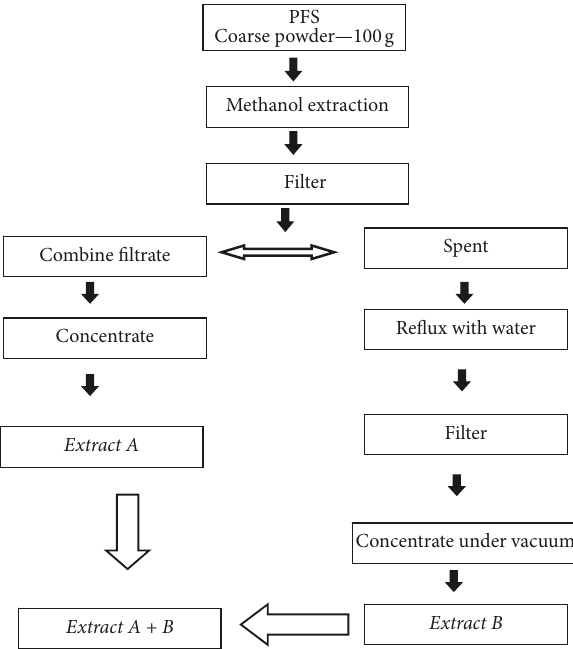
Figure 1: Extraction procedure of